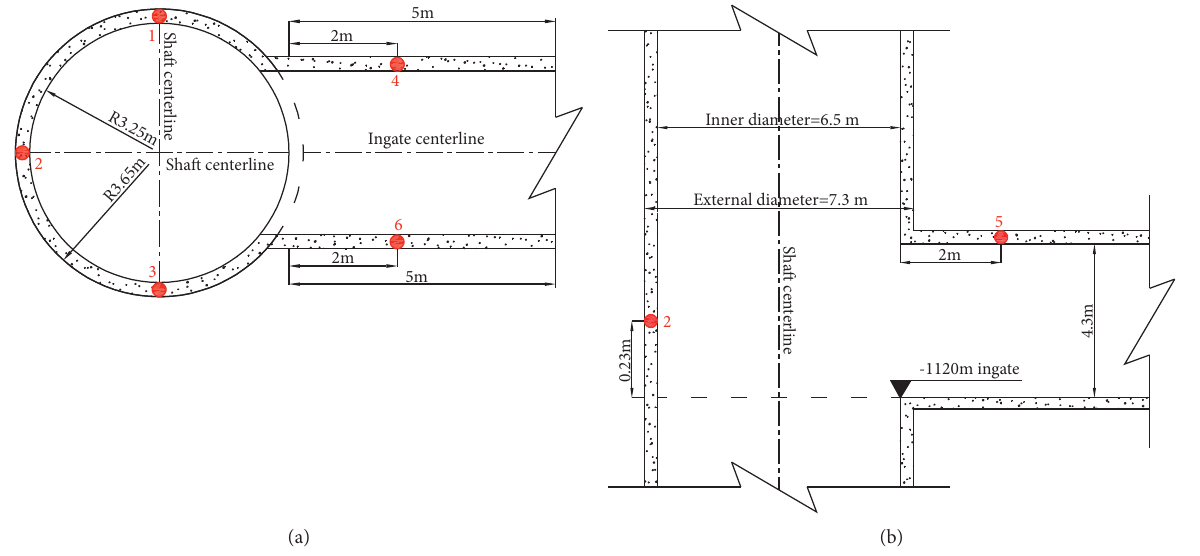
Figure 6: Layout of measuring